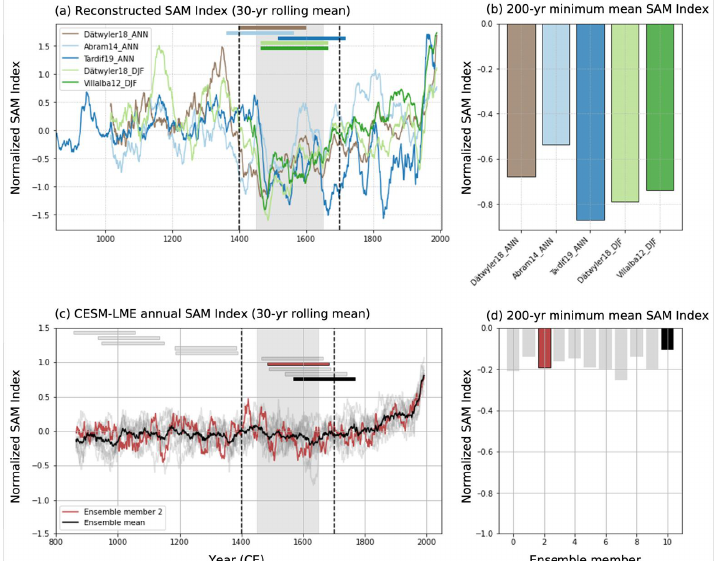
Figure 9. Last millennium trends in the Southern Annular Mode in ( a ) paleoclimate reconstructions and ( c ) the CESM- LME. ( a ) Reconstructed SAM index from Abram et al. [61] (annual), Dätwyler et al. [67] (DJF), Tardiff et al. [65] (annual), and Villallba et al. [69] (DJF). All indices were normalized and a 30-year rolling mean was applied to mitigate the influence of uncertainties in the paleoclimate records. Dashed lines denote a trend towards a more negative SAM in proxy records between 1400 and 1700 CE, with a core period of 1450 to 1650 CE (highlighted in grey). Colored bars denote the 200-year period with the lowest average SAM index; the average SAM index for each 200-year minimum period is shown in ( b ). ( c ) Same as in ( a ), but for the annual SAM index in LME full forcing simulations; the ensemble mean is shown in black; ensemble member 2 is highlighted in red to illustrate the modeled SAM variability in the individual ensemble members (shown collectively in grey) and; ( d ) same as in ( b ), but for LME full forcing simulations.